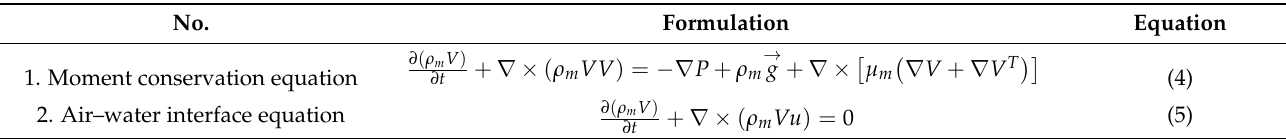
Table 3. Equations proposed by Navier-Stokes.